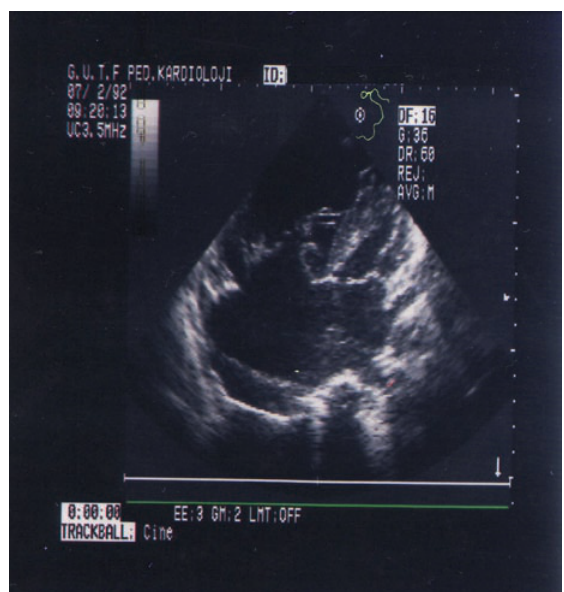
Figure 2. Short papillary muscle of septal division of tricuspid valve and atrial septal defekt in echocardiogram at apical four chamber view.